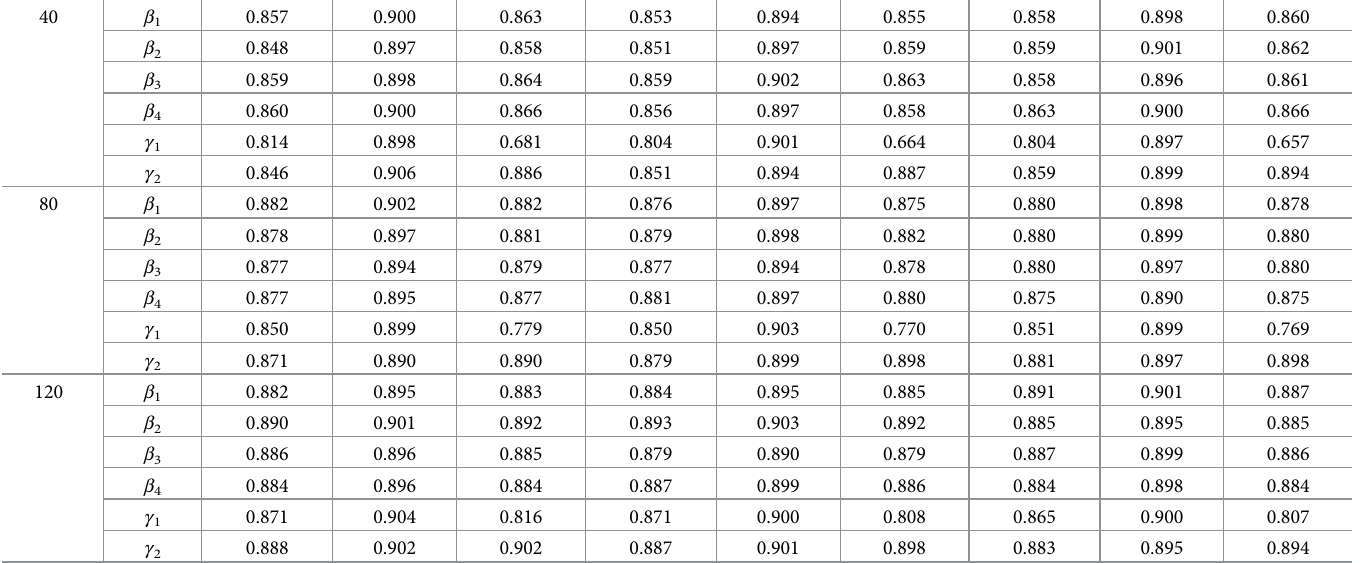
intensity of non-constant dispersion negatively affects the performances of the three confi- dence intervals considered. As the sample size increases the problem is smoothed. For instance, when n = 80, 1 − α = 0.90, λ � 128, only the bootstrap interval considers the possibility of linearity, namely: t